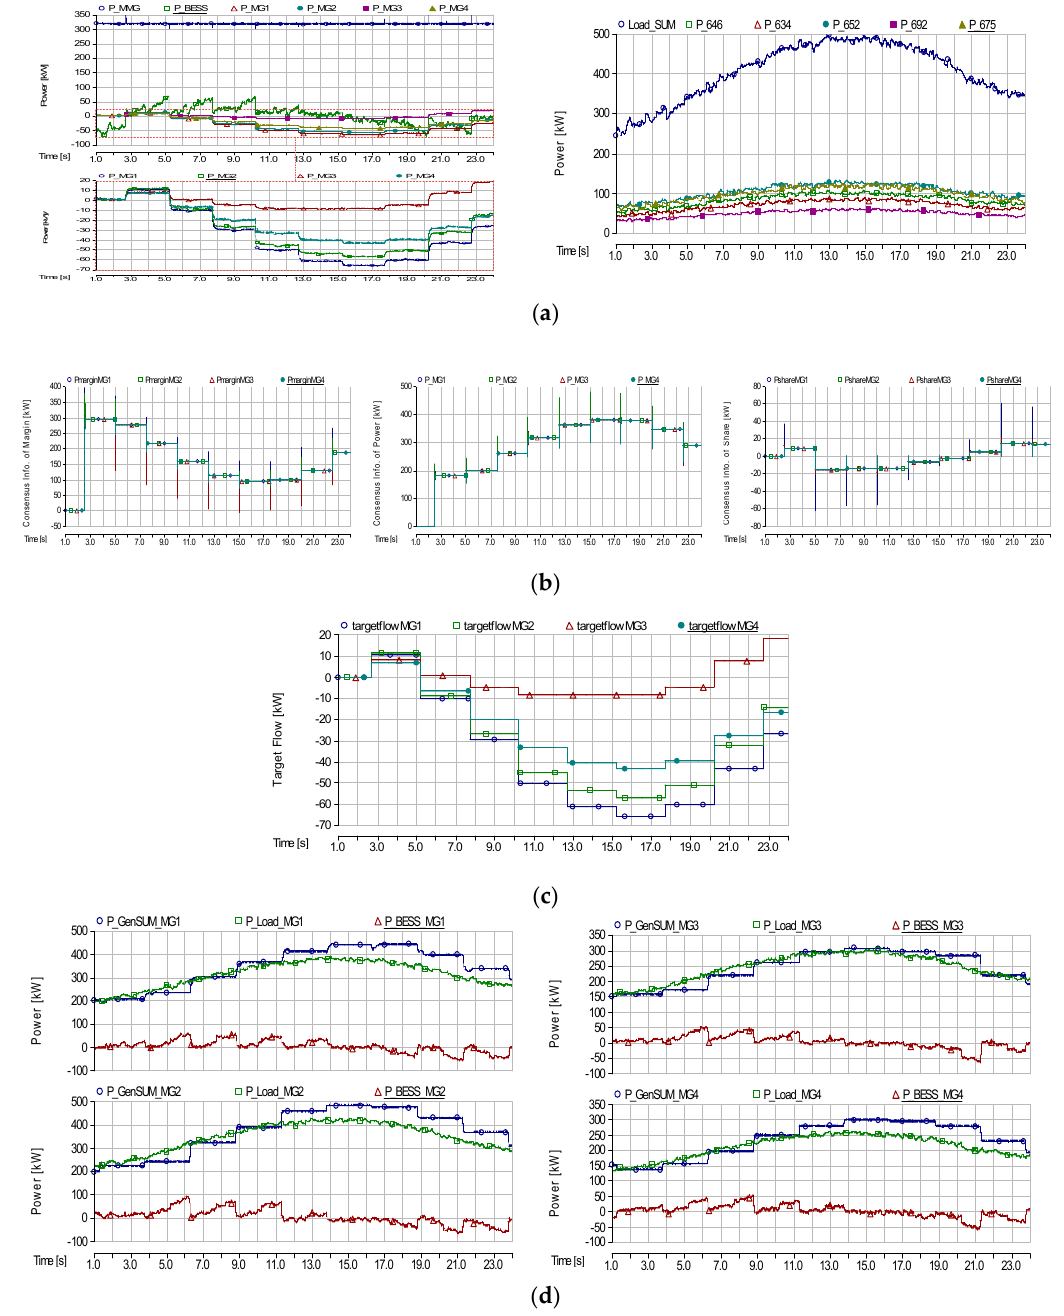
Figure 9. Simulation result in the MMG level (Case 3). ( a ) Power of the MMG flow, the MMG BESS, the MGs and load; ( b ) Convergence of the power margin, the current power, and sharing power of the MGs; ( c ) Target flow of each MG PCC; ( d ) Total generation power, load, and the MG BESS output of each MG.